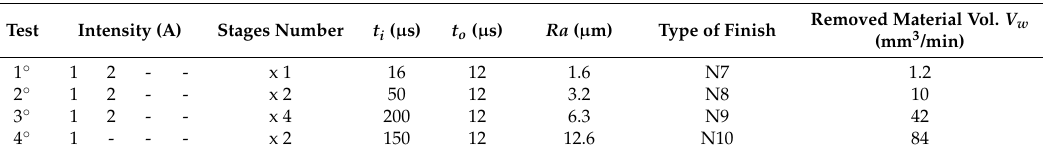
Table 7. Finishing parameters for the extruded